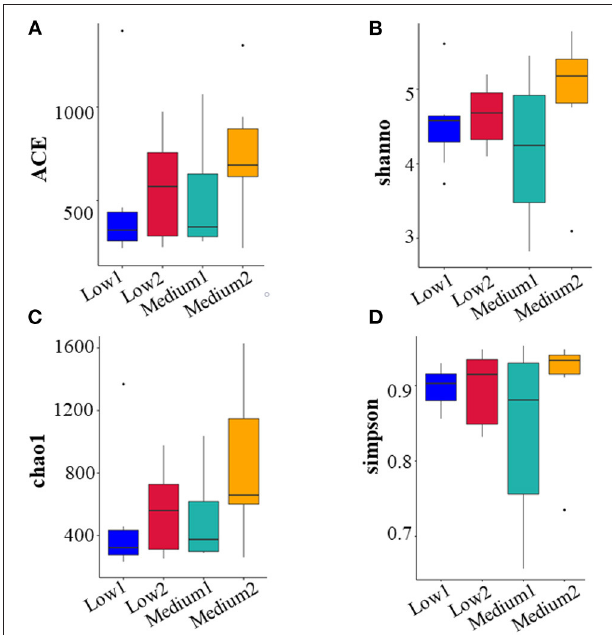
FIGURE 5 | Analysis and comparison of multiple indexes before and after the intervention in the Low and the Medium groups. The study of microbial diversity in community ecology can reflect the abundance and diversity of microbial communities through a single sample diversity analysis [ α (alpha) diversity], including a series of statistical analysis indexes to estimate the species abundance and diversity of environmental communities diversity. The picture showed the four indexes [ACE (A) , shannon (B) , chao1 (C) , and simpson (D) ] of the α diversity analysis of 6 subjects in the Low group and Medium group respectively before and after the intervention. The higher the values of the four indexes, the more abundant species in the community. Low1 means before the intervention in the low-dose group, Low2 means after the intervention in the low-dose group, Medium1 means before the intervention in the medium-dose group, and Medium2 means after the intervention in the medium-dose